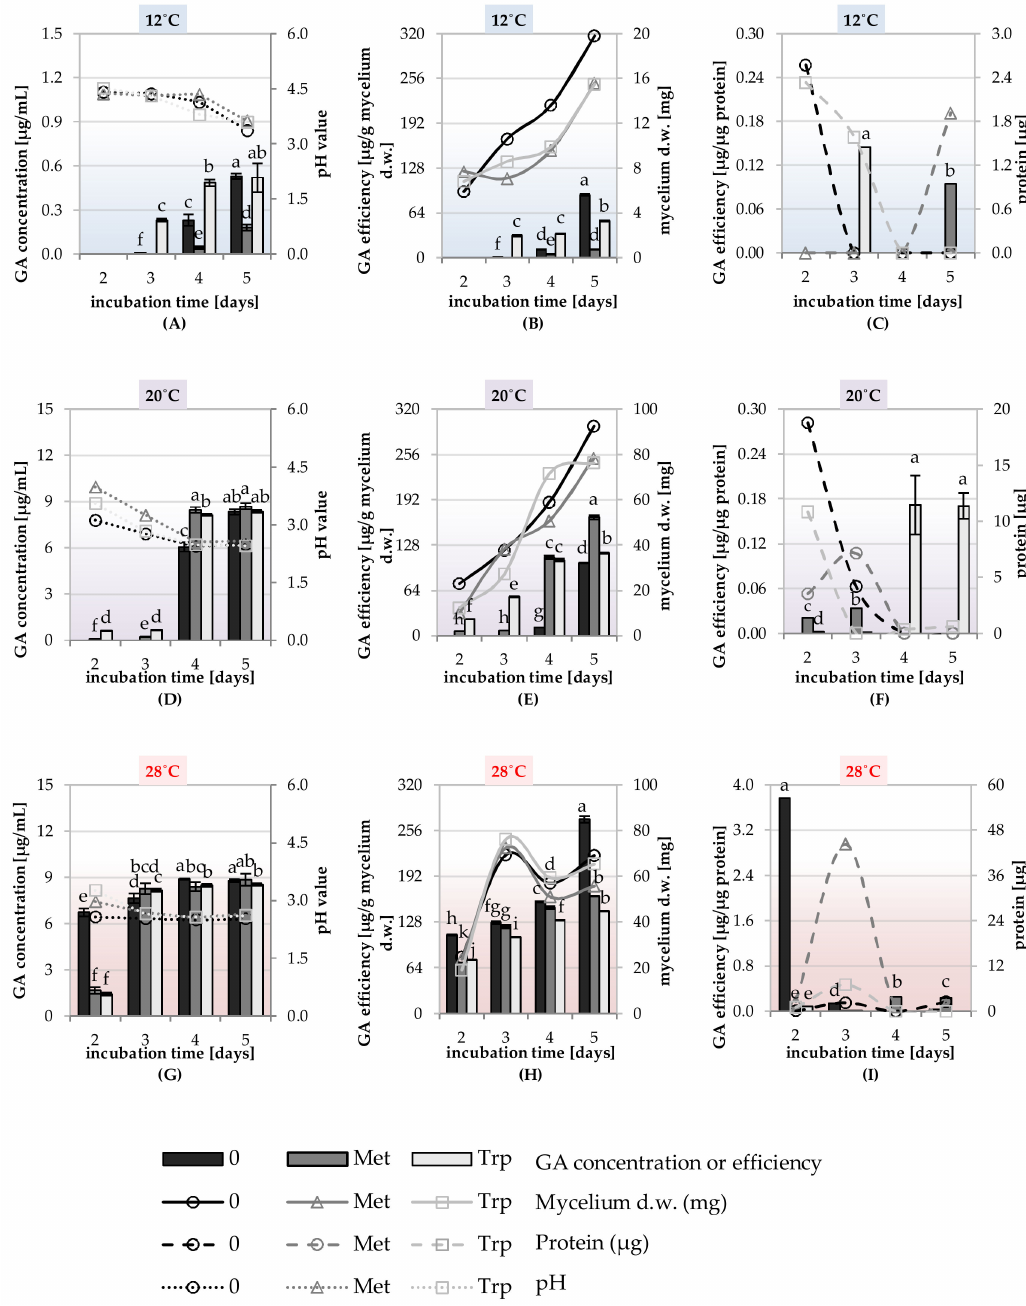
Figure 9. The gibberellic acid (GA) concentration and e ffi ciency of GA synthesis in Trichoderma DEMTkZ3A0 strain cultures grown in RB modified medium supplemented with 3.0 mM Met and Trp or without amino acids after 2, 3, 4, and 5 days incubation at 12 ◦ C ( A , B , C ), 20 ◦ C ( D , E , F ) and 28 ◦ C ( G , H , I ). Bars represented standard deviations (SD). Values followed by di ff erent letters are significantly di ff erent (one-way analysis of variance (ANOVA) followed by a Tukey’s post hoc test with the significance evaluated at p <